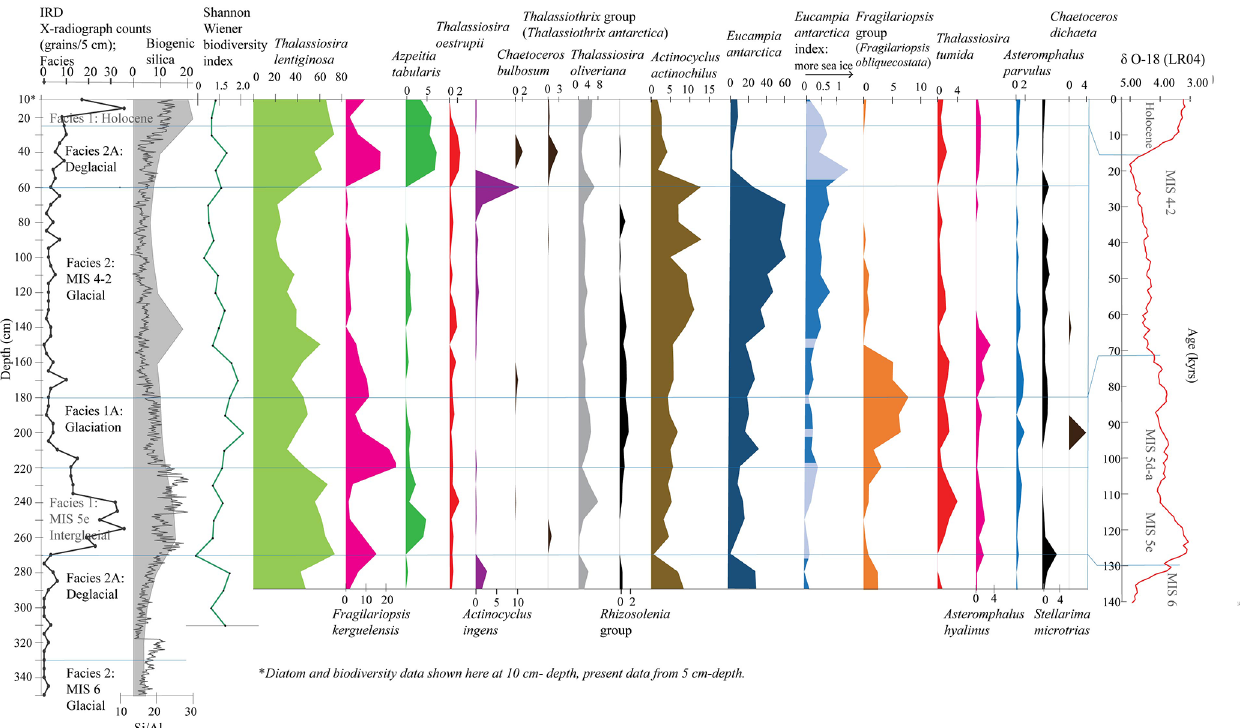
Figure 3. Tan_44 distribution of main species, species groups and Eucampia index (terminal/intercalary valve ratio). Results include IRD counts, facies interpretation (vertical lines), biogenic silica (%), Si/Al (XRF) and the Shannon–Wiener biodiversity index. The facies model is shown in comparison to LR04 (Lisiecki and Raymo, 2005). Species in black are not included in statistical analysis due to lower abundance ( > 1 . 8% in just one sample). These are the Rhizosolenia group (mainly Rhizosolenia antennata var. semispina and Rhizosolenia antennata var. antennata ), the Thalassiothrix group (mainly Thalassiothrix antarctica ), Stellarima microtrias , Chaetoceros bulbosum and Chaetoceros dichaeta . Eucampia index was also not included in statistical analysis; its distribution in dark blue shows where total Eucampia antarctica counts are > 100 valves per sample, while the light blue areas show samples with < 100